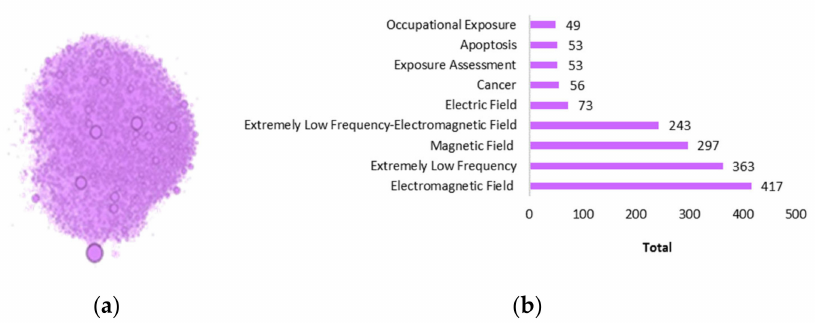
Figure 7. Representation of the ELF community in health: ( a ) isolated distribution of publications. ( b ) keywords of the